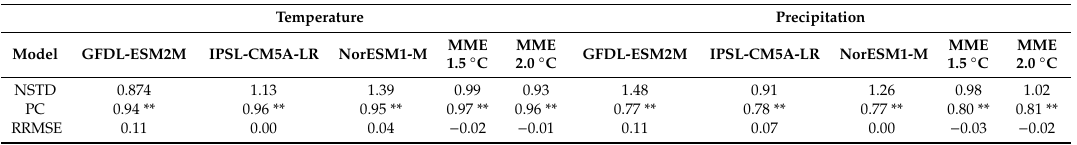
Table 7. Normalized spatial standard deviation (NSTD), Pearson’s correlation (PC), and relative root mean error (RRMSE) for observed and simulated